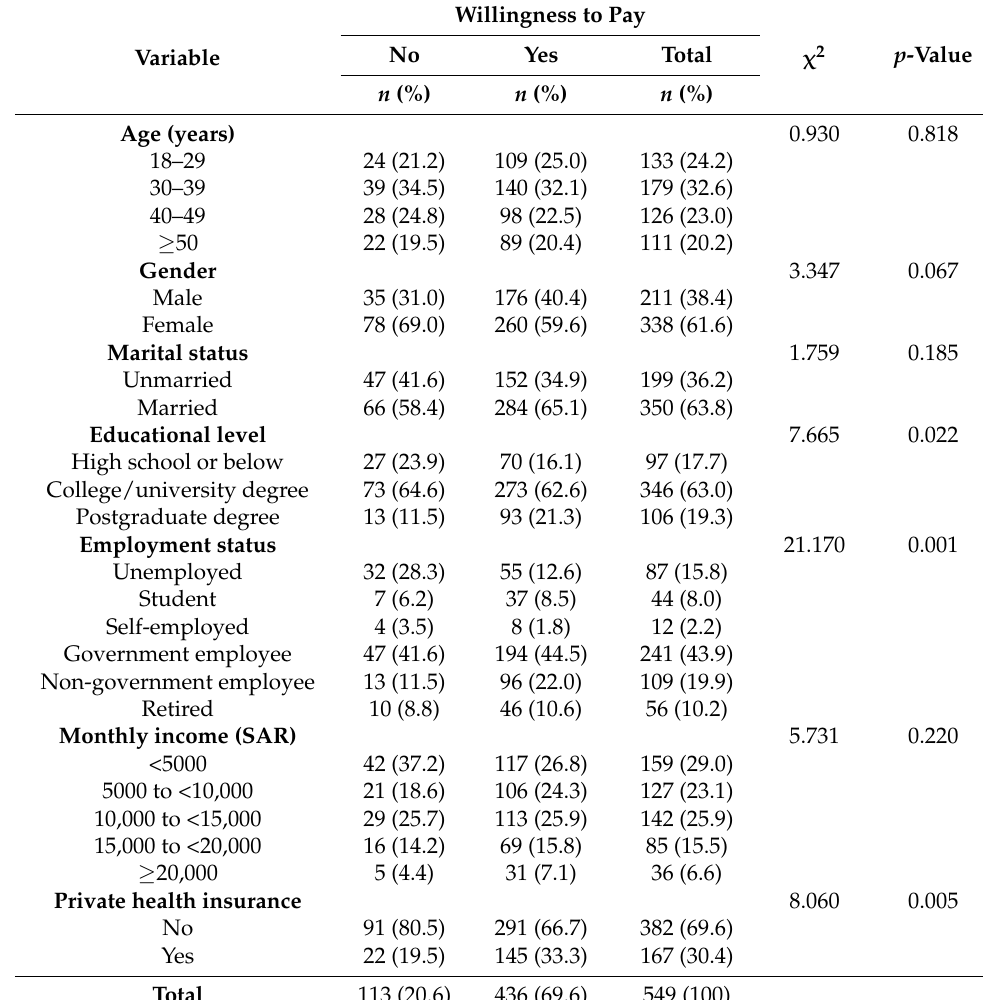
Table 2. Bivariate analysis of socioeconomic factors and willingness to pay for immediate public dental